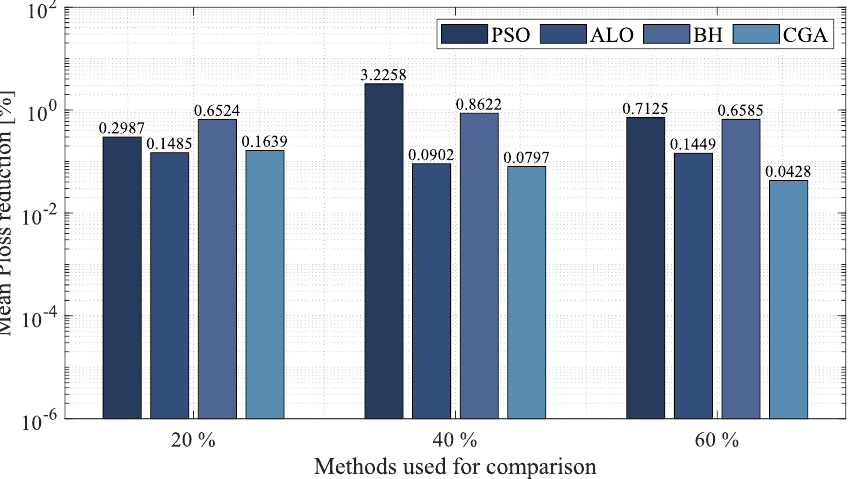
Figure 16. Percentage of reduction of average power losses obtained by the MVO in the 10-node mesh test system compared to other methodologies.